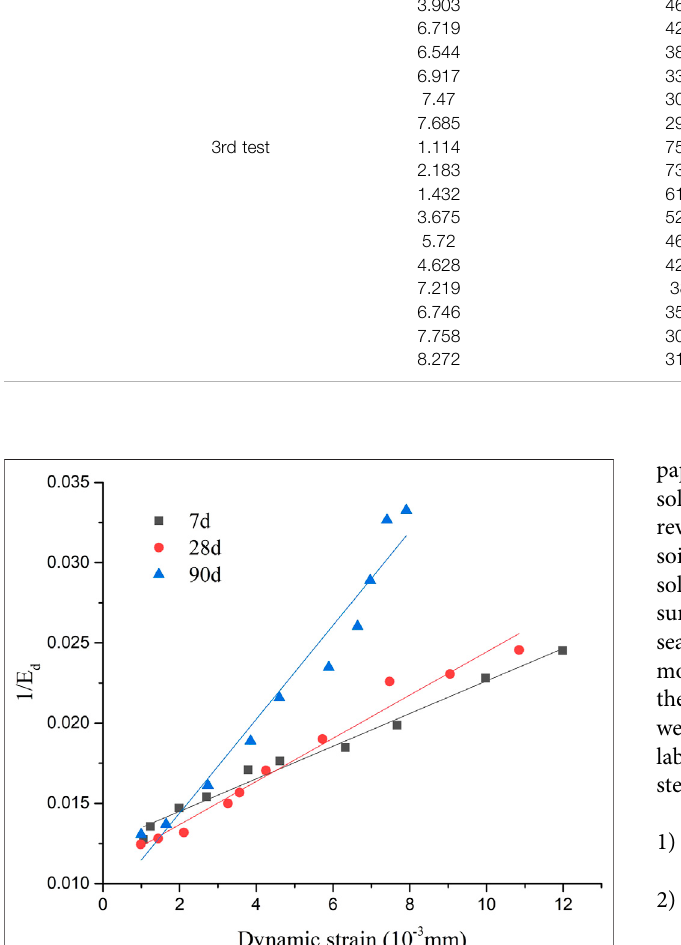
Frontiers in Materials |